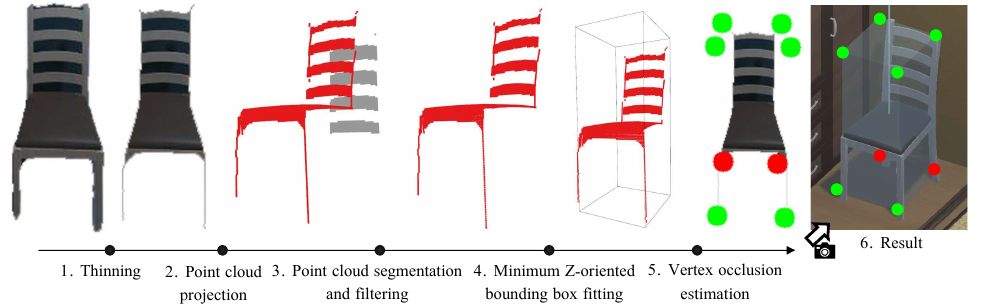
Figure 3. Overview of the process used to build the models of the detected objects. Each detected object mask is first subjected to a thinning step to remove spurious pixels while maintaining the object structure. Then, it is projected in 3D space to obtain a point cloud which we segment and filter—removing the gray points shown. From the resulting point cloud, we fit a Z-oriented bounding box, whose vertices we evaluate to check if they are visible. The latter is represented in the figure using red dots for the non-visible vertices and green dots for the visible